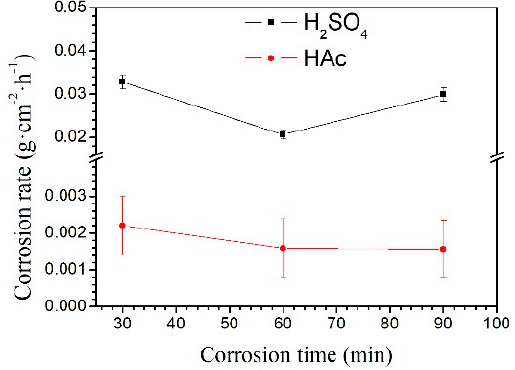
Figure 4. The Mg–Al alloy's corrosion rates in H 2 SO 4 and HAc solutions for 30, 60, and 90 min.